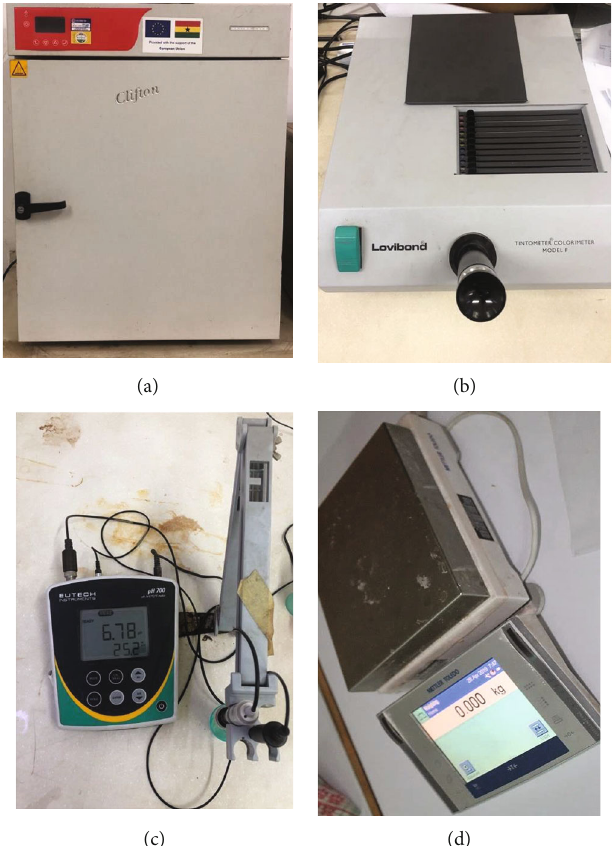
Figure 2: Applied equipment: (a) Clifton laboratory oven, (b) Lovibond tintometer colorimeter, (c) pH-700 meter, and (d) precision balance.